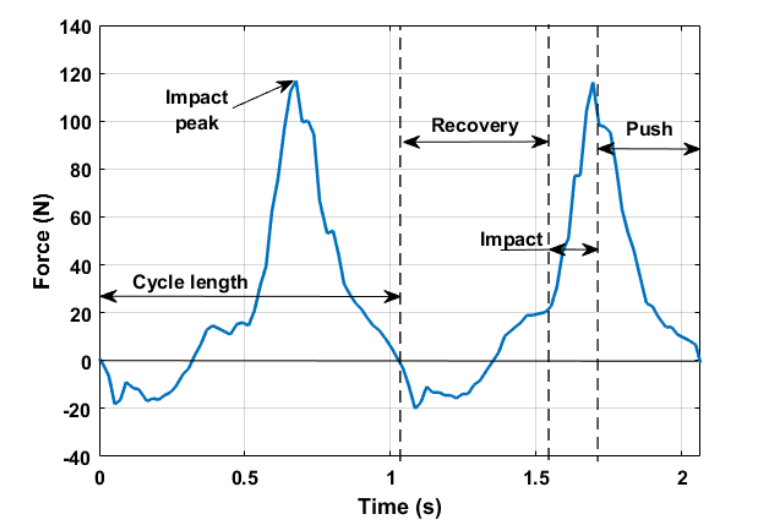
Figure 8. Force measurements along the longitudinal pole